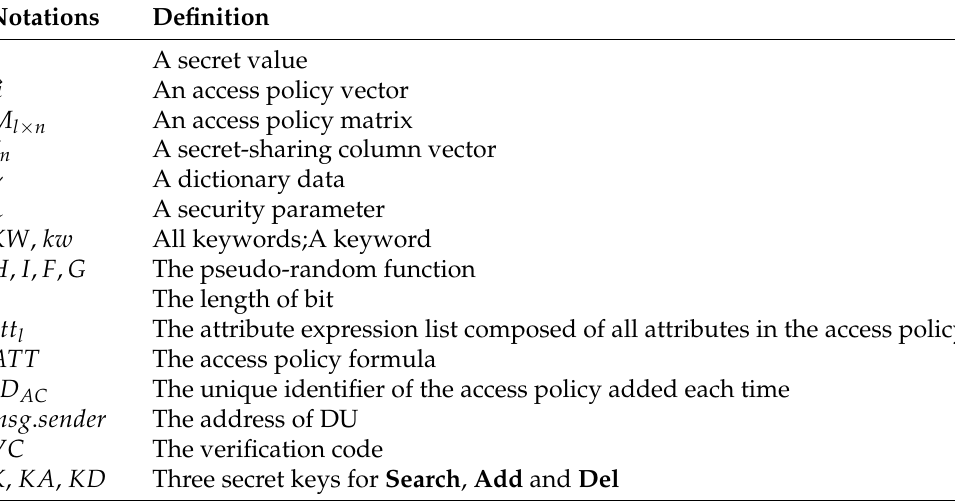
Table 2. The standard